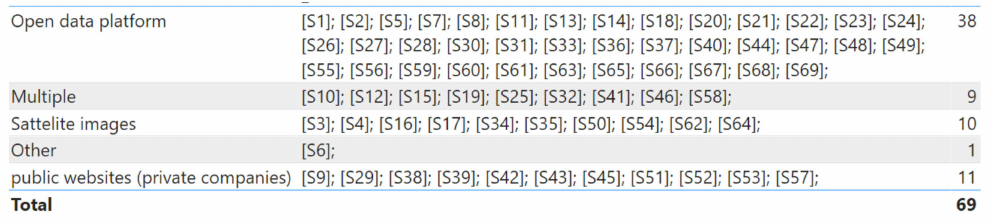
Figure 12. List of papers classified by the sources for open data used in ML